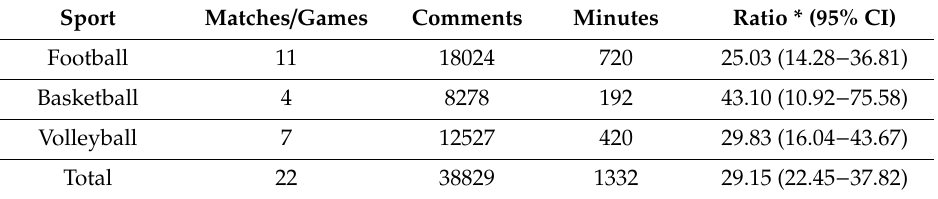
Table 2. Games and matches, comments, minutes, and ratio of comments observed per